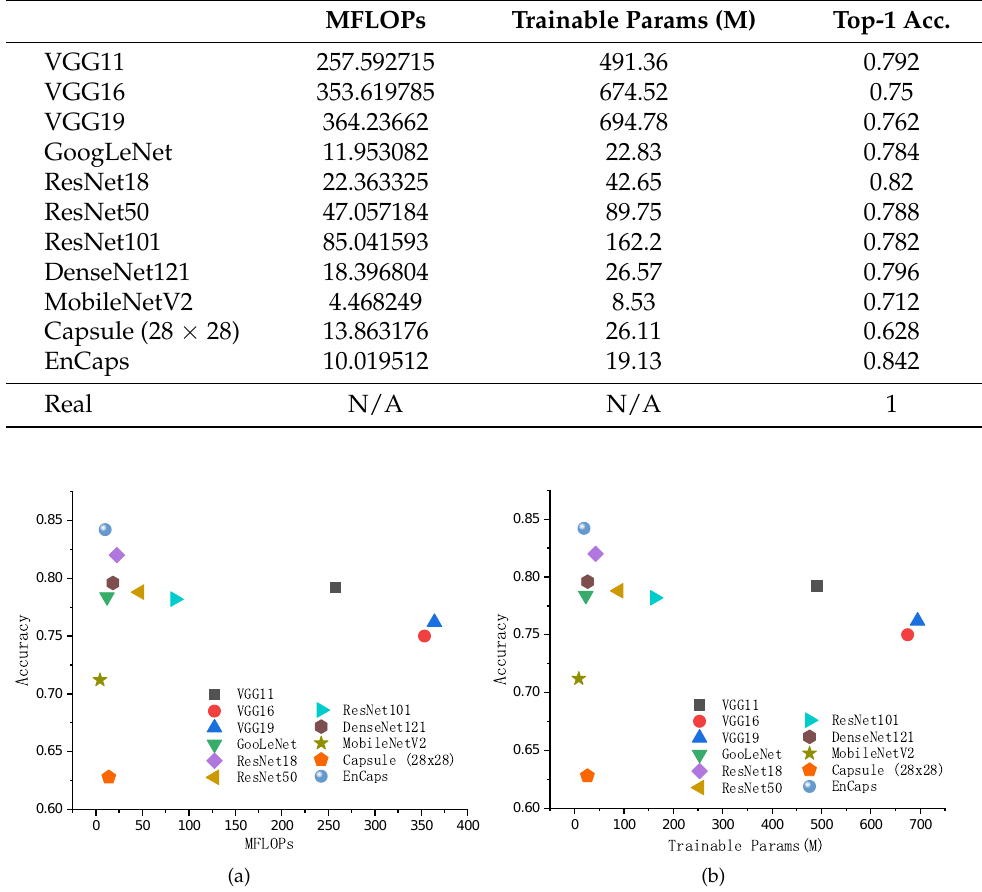
Table 4. The comparison of calculation, parameter, and accuracy between different networks.